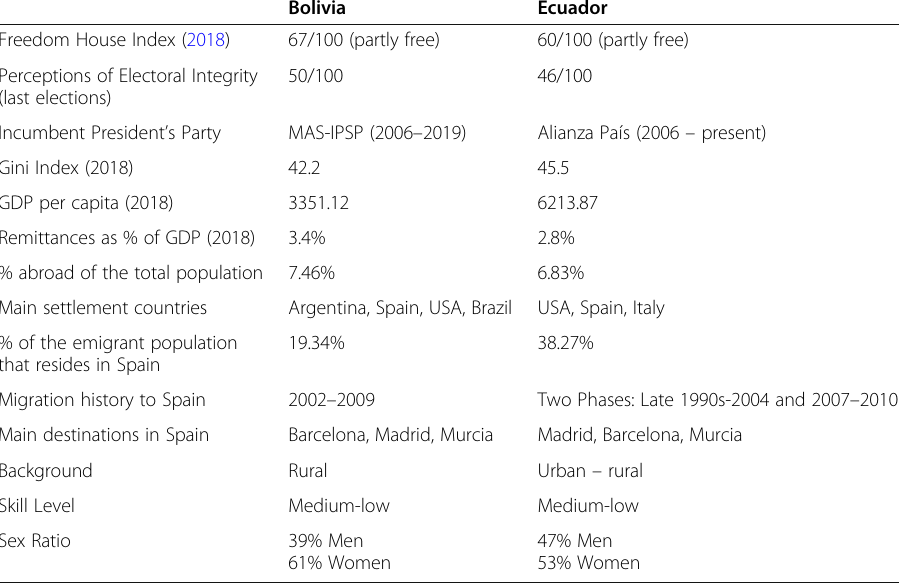
Table 1 Country